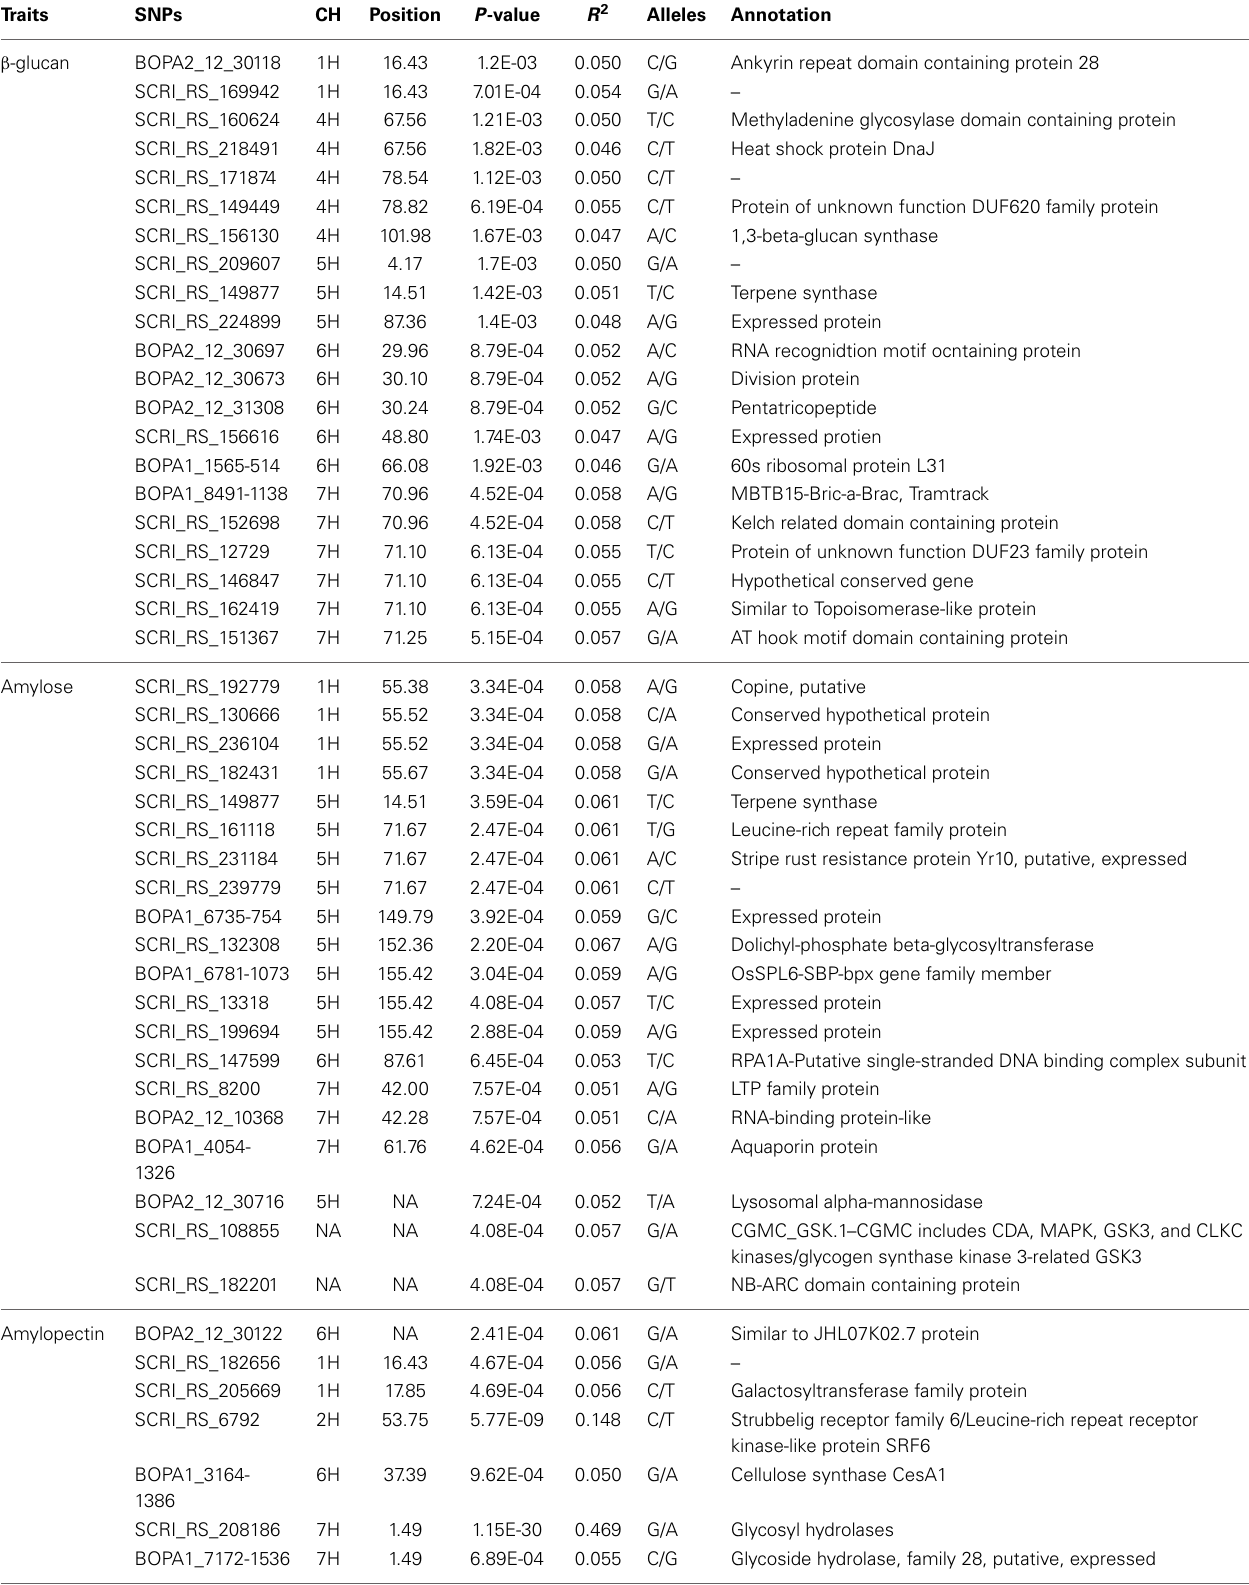
Table 1 | Associated SNPs for β -glucan, amylose and amylopectin content with the highest possibility called by K model. Traits SNPs CH Position P -value R 2 Alleles Annotation β